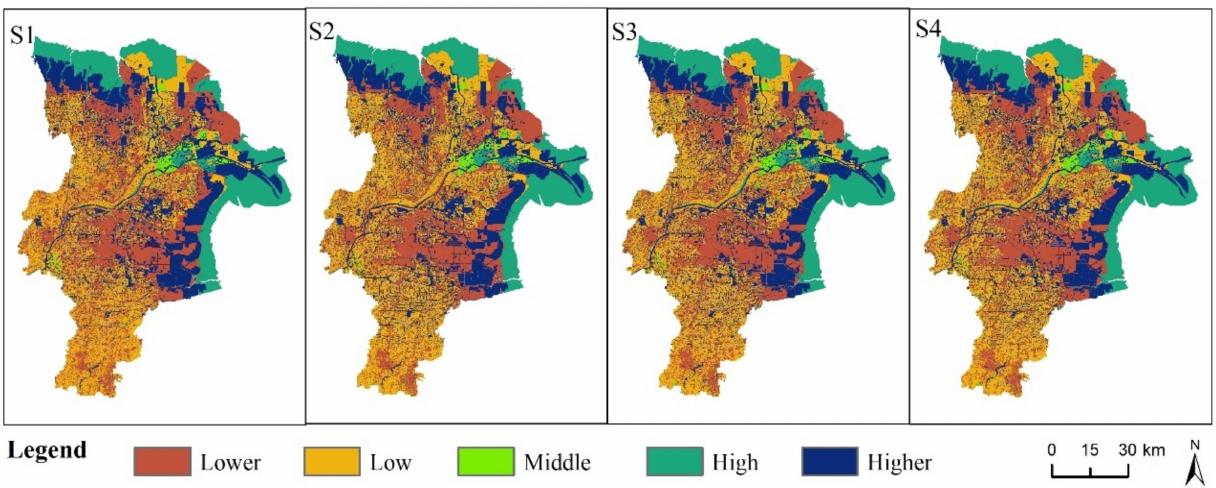
Figure 8. Spatial distribution of habitat quality in Dongying City in ( S1 ) ( S2 ), ( S3 ), and ( S4 ). Note: S1, S2, S3 and S4 refer to the business as usual scenario, the fast-cultivated land expansion scenario, the ecological security scenario and the sustainable development scenario,